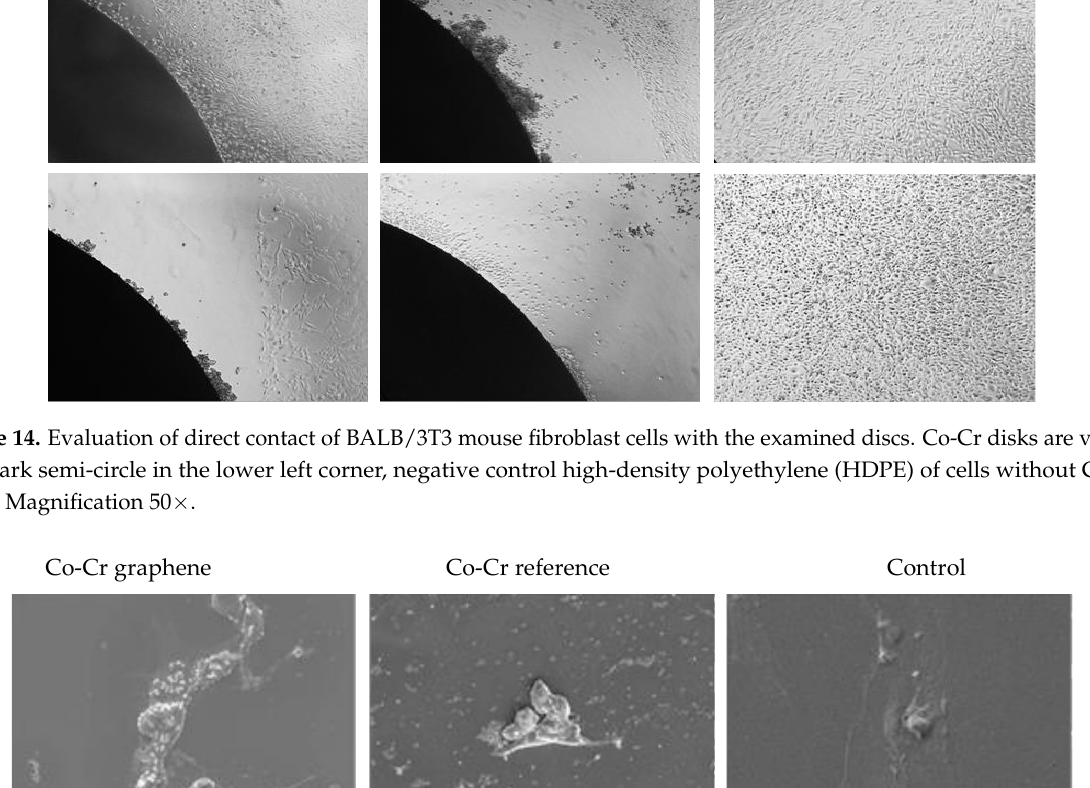
Figure 15. Evaluation of direct contact of BALB/3T3 mouse fibroblast cells with the examined discs. Deposits and cells are marked in orange. Magnification 2000×.